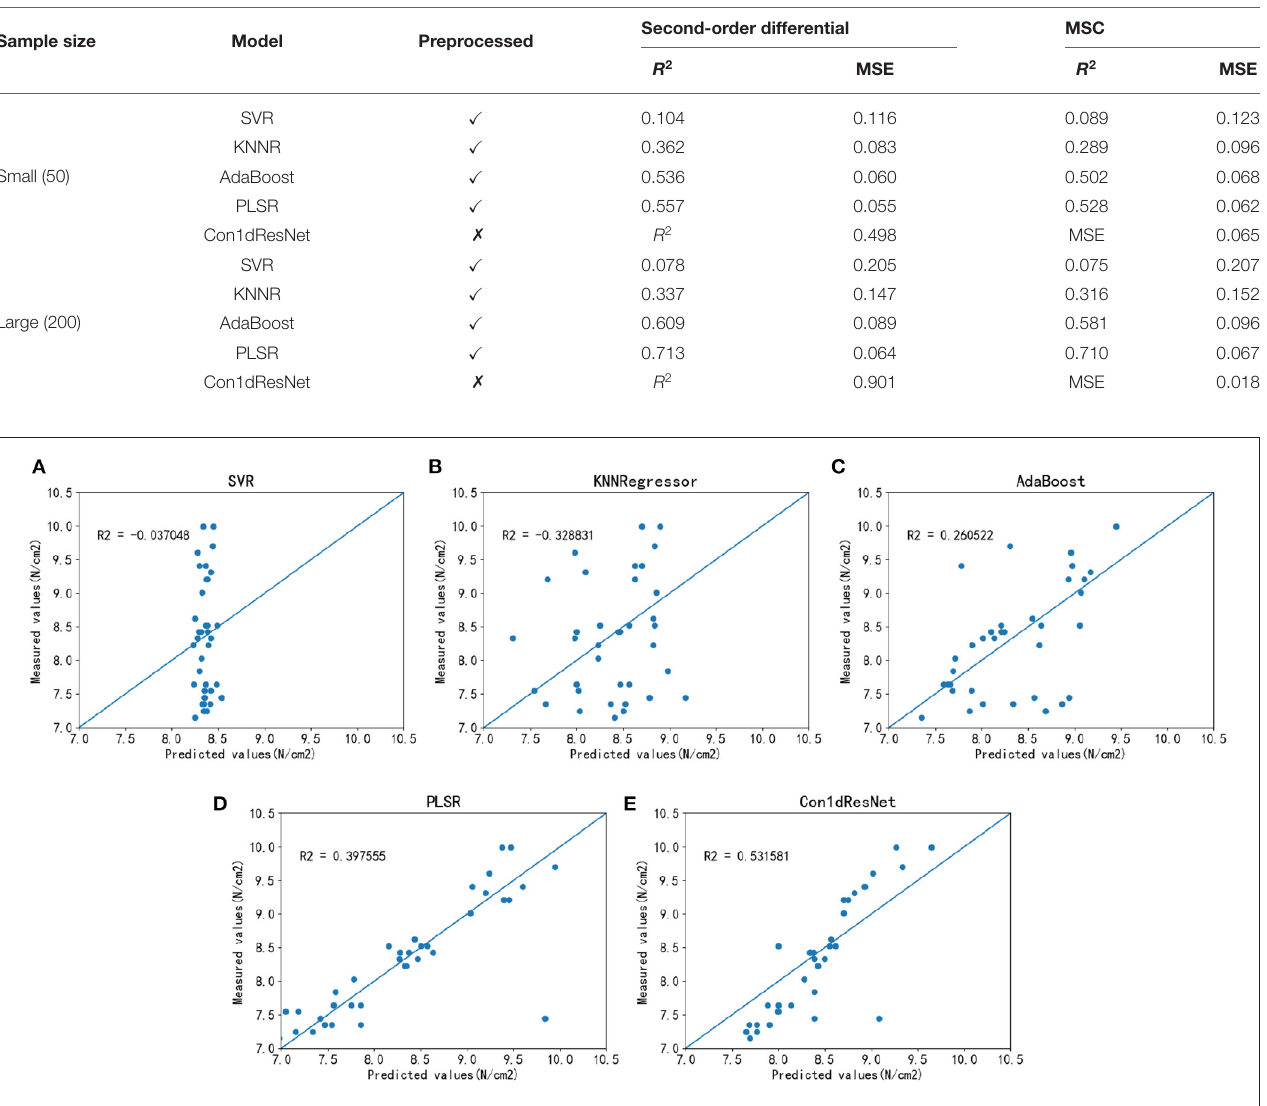
TABLE 3 | R 2 and MSE of estimated SSC for each model.